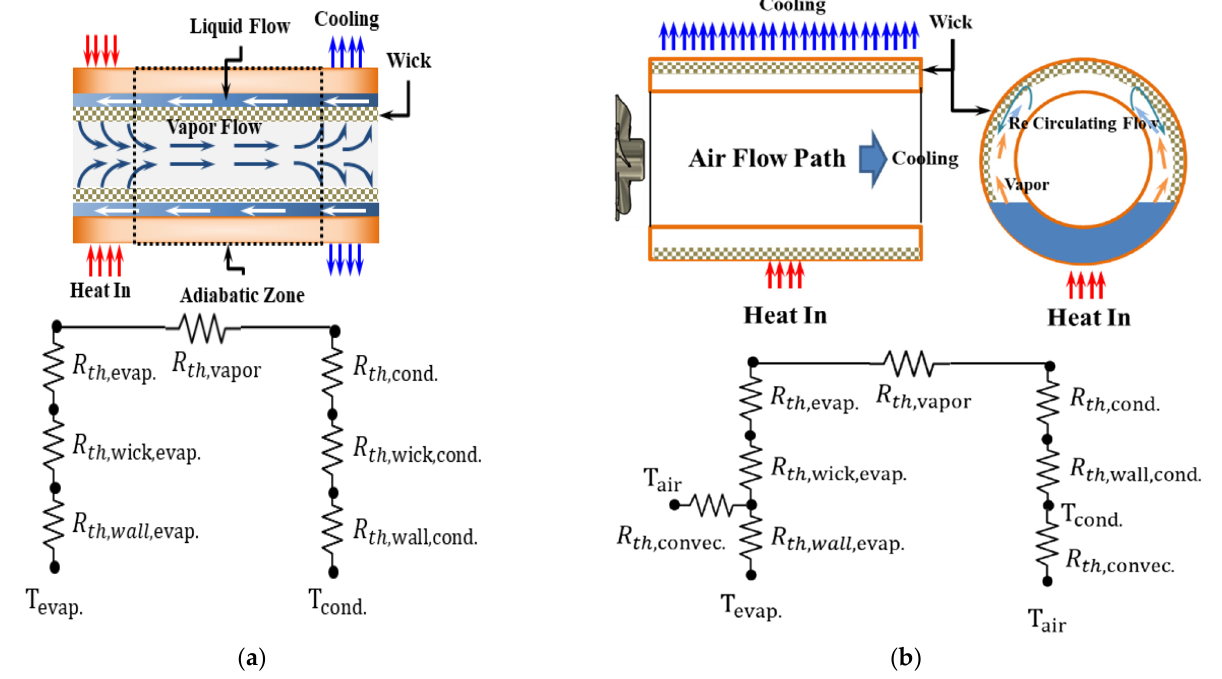
Figure 1. Thermal Resistance Network of a Conventional Heat Pipe and a CAHP. ( a ) Thermal Resistance Network of a Conventional Heat Pipe. ( b ) Thermal Resistance Network of a